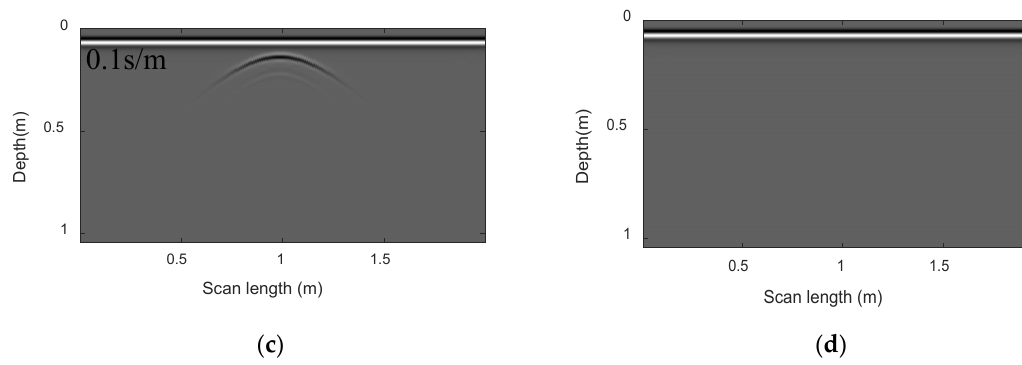
Figure 5. Simulation results ( a , b ) two conductive objects buried in a wet sand medium at a depth of 0.3 and 0.7 m ( c , d ) object detection radargrams.